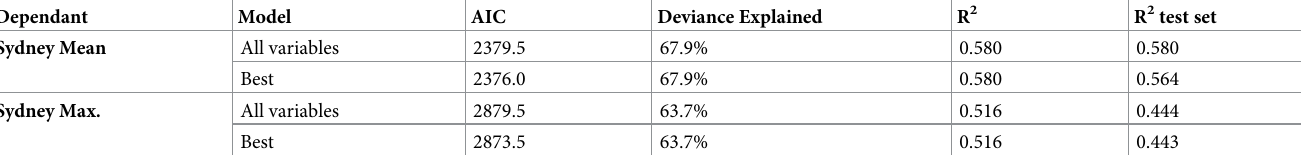
Table 2. GAM accuracy results for models with all variables and best models from the model selection process.